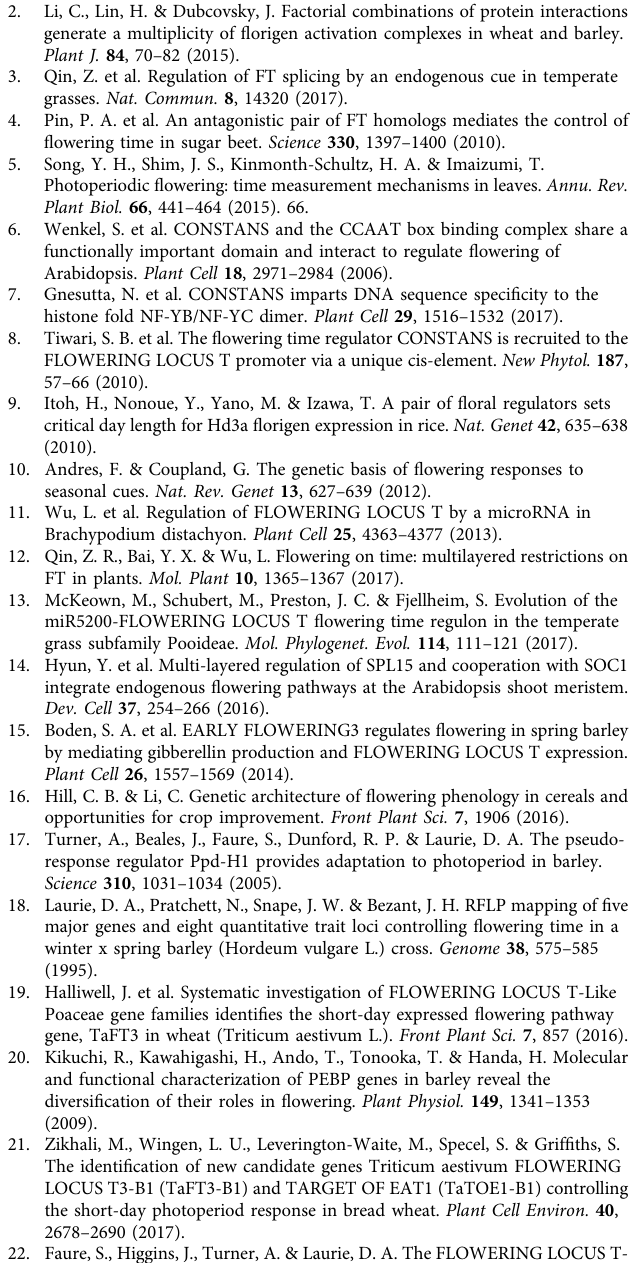
Supplementary Table 1. PCR products were cloned into the Eco RI and Bam HI sites of the DNA-binding domain vector pGBKT7 or the GAL4-activation domain vector, pGADT7. Both vectors were co-transformed into yeast strain AH109 using the lithium acetate-based transformation protocol. The positive colonies were selected SD/-Leu/-Trp (-LT) medium and then used for a growth assay on selective SD/-Leu/-Trp/-His/-Ade medium (-LTHA) supplemented with 1 mM 3-AT. The interactions were observed after 4 days of incubation at 30 ℃ . The quantitative interaction assays were performed using Chlorophenol red- β -D-galactopyranoside (Sigma) as substrates 3 . Yeast cells were broken by the freeze/thaw method and mixed with Chlorophenol red- β -D-galactopyranoside in a reaction Buffer. Reac- tions were stopped by adding 3 mM ZnCl 2 , and the color change of the reaction was measured at 578 nm using a UV/Vis spectrophotometer. BiFC assays . Full-length coding sequences of the indicated proteins were con- structed into vectors containing either N-terminal or C-terminal-enhanced yellow fl uorescence protein fragments. Primers for the constructs are presented in Sup- plementary Table 1. These resulting constructs were transformed into A. tumefa- ciens strain EHA105, which was then cultured overnight and adjusted to OD600 = 0.8. An equal volume of each culture was mixed together for injection. Sets of combination were co-in fi ltrated to 4-week-old N. benthamiana leaves. YFP fl uor- escence was observed using a confocal laser scanning microscope (Zeiss,